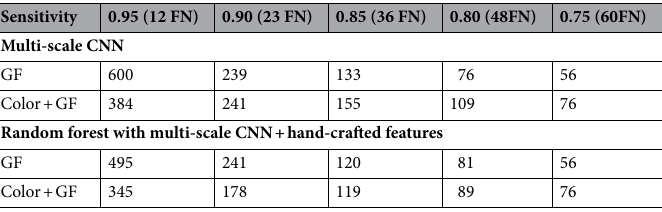
Table 3. Effect of color image as input and random forest on false-positive reduction performance. The number of FP candidates at different sensitivities in the range of 0.75–0.95 are compared.